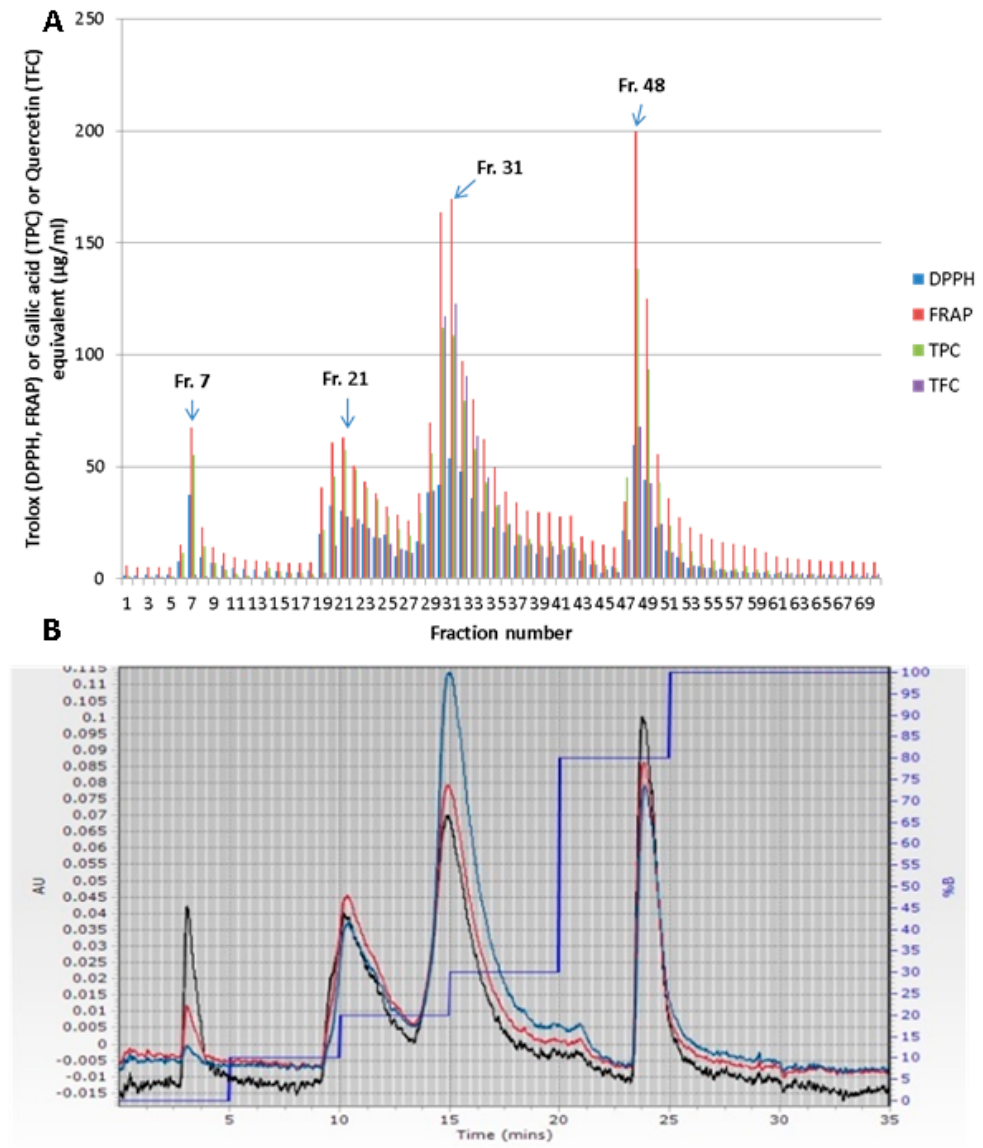
Figure 4. ( A ) Antioxidant activities, total phenol, and total flavonoid contents of the fractions obtained from flash chromatography of red onion extract, ( B ) Flash chromatogram of the crude red onion extract (blue, red, and black lines indicated the chromatograms obtained at 360 nm, 320 nm, and 280 nm wavelengths respectively) Fraction numbers in 3A equals time intervals in 3B.